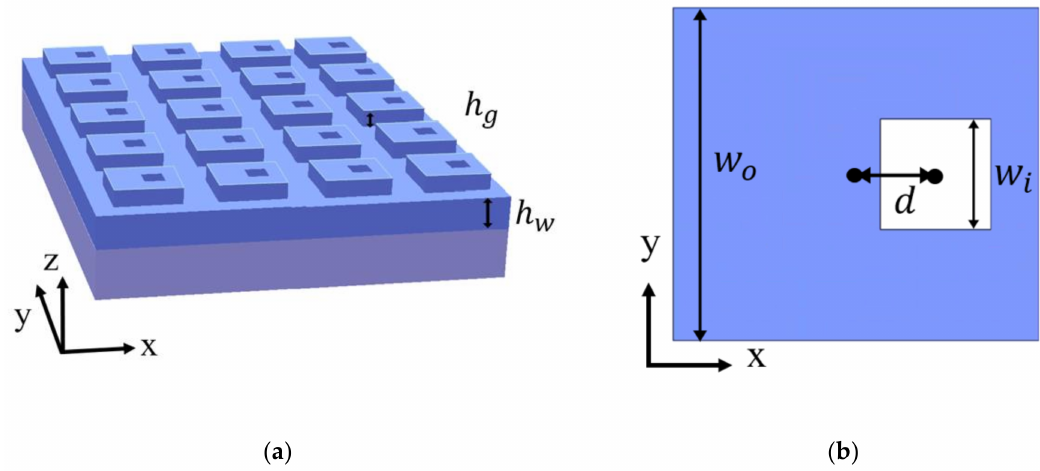
Figure 1. ( a ) The schematic of asymmetric metasurface structure and ( b ) the top view of gratings. Rigorous coupled-wave analysis (RCWA) was used in the simulations to calculate the Q factor from the spectral responses and finite element method (FEM) was used to calculate the electric field distributions of the structures. Q was calculated by resonant wavelength divided by FWHM [32]. The ranges of peaks were partitioned by difference.